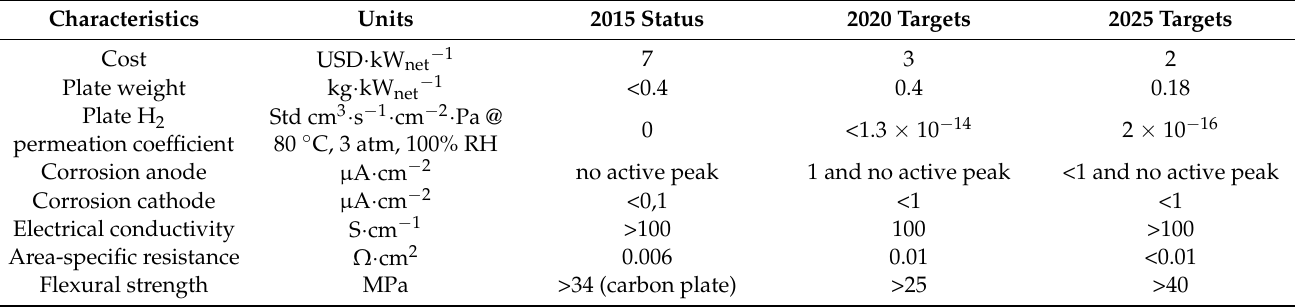
Table 1. U.S. Department of Energy technical targets for BPs for transportation applications